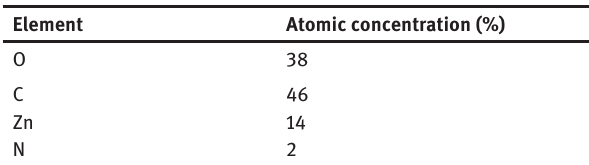
Figure 7 : Deconvoluted XPS Zn 2p peak. Table 1 : Concentration of elements in the deposited films obtained by XPS measurements.